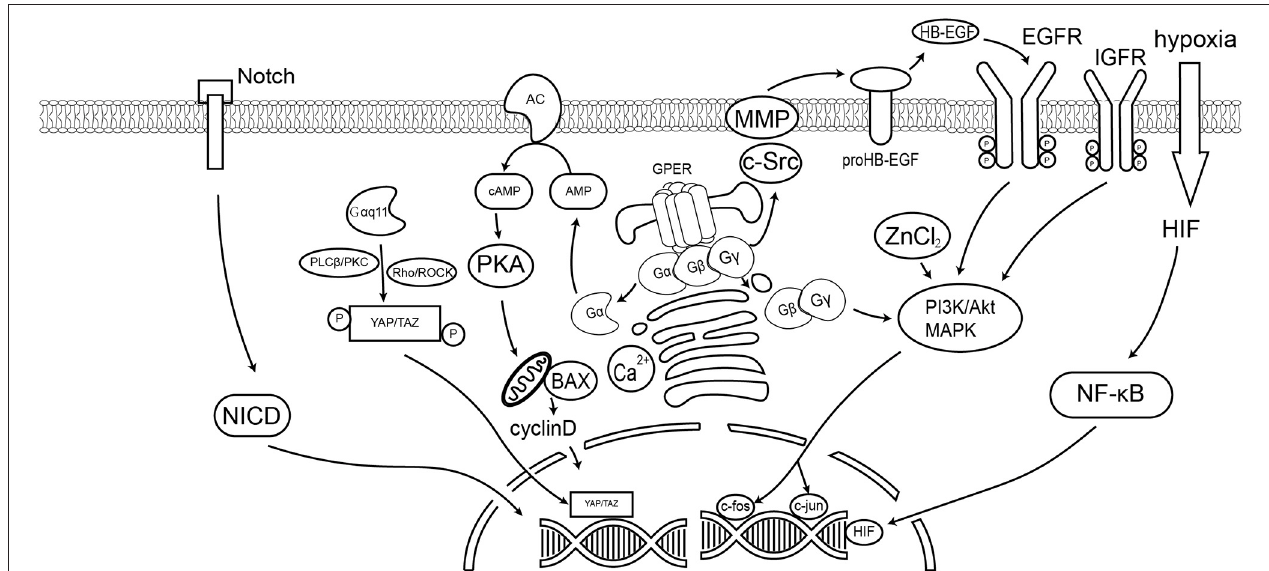
FIGURE 1 | GPER signaling pathways in cancer cells. This diagram summarizes the signaling events discussed in this article. GPER mediated the non-genomic effect of E2 and active the G-protein dependent signaling, including the cAMP, Ca 2 + , Akt, and YAP/TAZ pathways. GPER could also trigger the ligand-dependent transactivation of receptor tyrosine kinase, such as EGFR. Previous reports also suggest GPER could affect the Notch signaling and hypoxia stimulated HIF pathway.